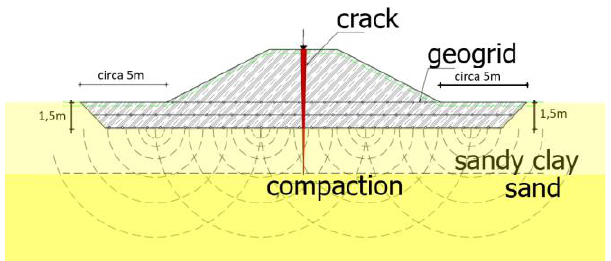
Figure 14. Another solution for sections with high liquefaction potential consists of removal of the embankment and the subsoil to a depth of at least 1.5 m from the ground surface, rapid impulse compaction, replacement of the foundation soil with the installation of geogrids, and construction of the embankment to the designed height.